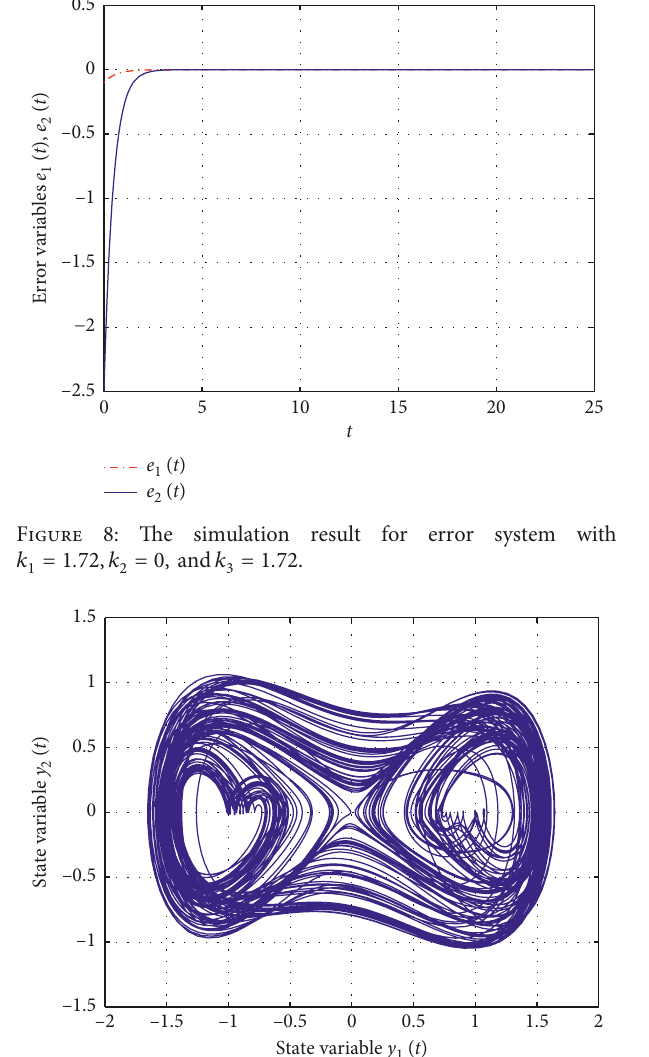
Figure 10: The simulation result for the error system with � 7 . 1 , k � 0 , and k � 7 . 1. k 1 2 3